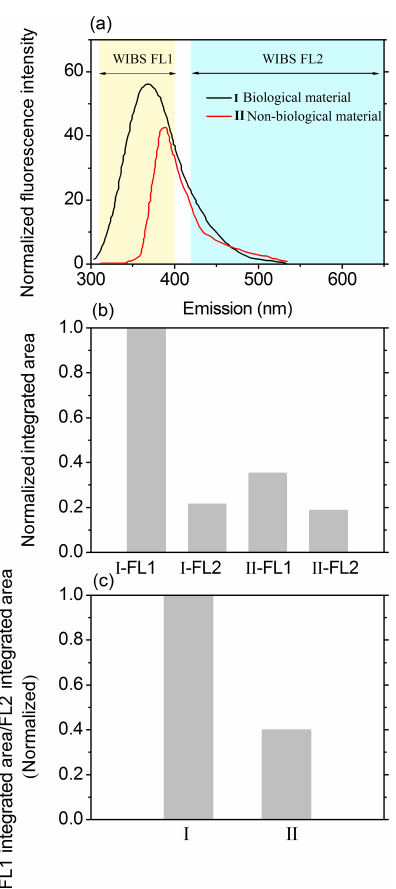
Figure 2. (a) Normalized fluorescence emission spectra of two fluorescent compounds: I (black line, biological material) and II (red line, non-biological material) for excitation wavelengths at λ ex = 280 nm. Shadow areas indicate the excitation wavebands of FL1 and FL2 channels of WIBS. (b) Integrated fluorescence inten- sity of two compounds in two bands (FL1 and FL2). (c) The ratio of fluorescence intensity from different WIBS channels ( I FL1 / I FL2 ) of I and II compounds. The fluorescence emission spectra are obtained from Pöhlker et al.